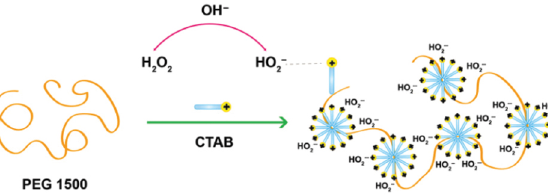
Figure 8: Schematic illustration for the concentration of hydroperoxyl anions in CTAB-PEG microenvironment. Reprinted with permission from Shi et al.